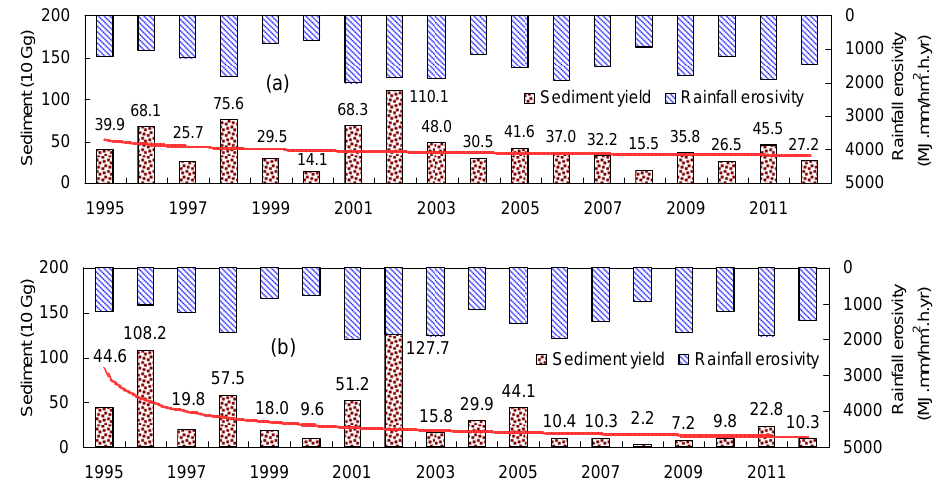
Figure 8. Comparative variations of sediment yield and rainfall erosivity in the Majiagou River watershed from 1995 to 2012: (a) the established dynamic model; (b) the modified dynamic model.